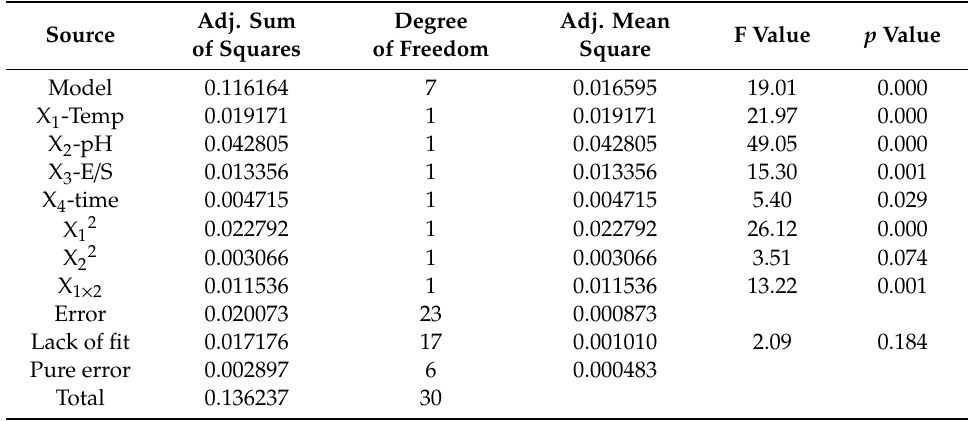
Table 3. Analysis of variance (ANOVA) for the quadratic polynomial model for level optimization of pectic galactan-oligosaccharides (PGOs) using endo- β -1,4-galactanase from C. japonicus .